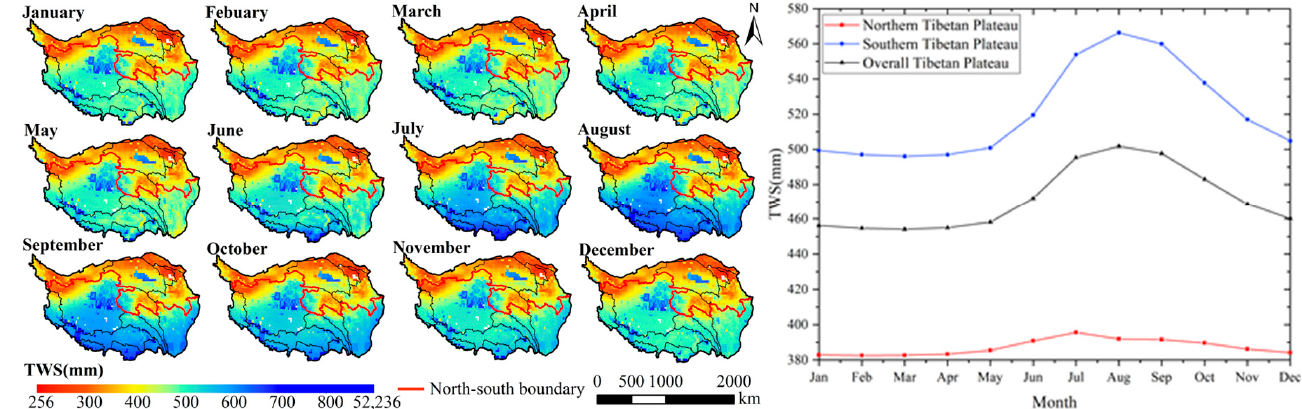
Figure 5. Spatial distributions of intra-annual terrestrial water storage over the Tibetan Plateau.